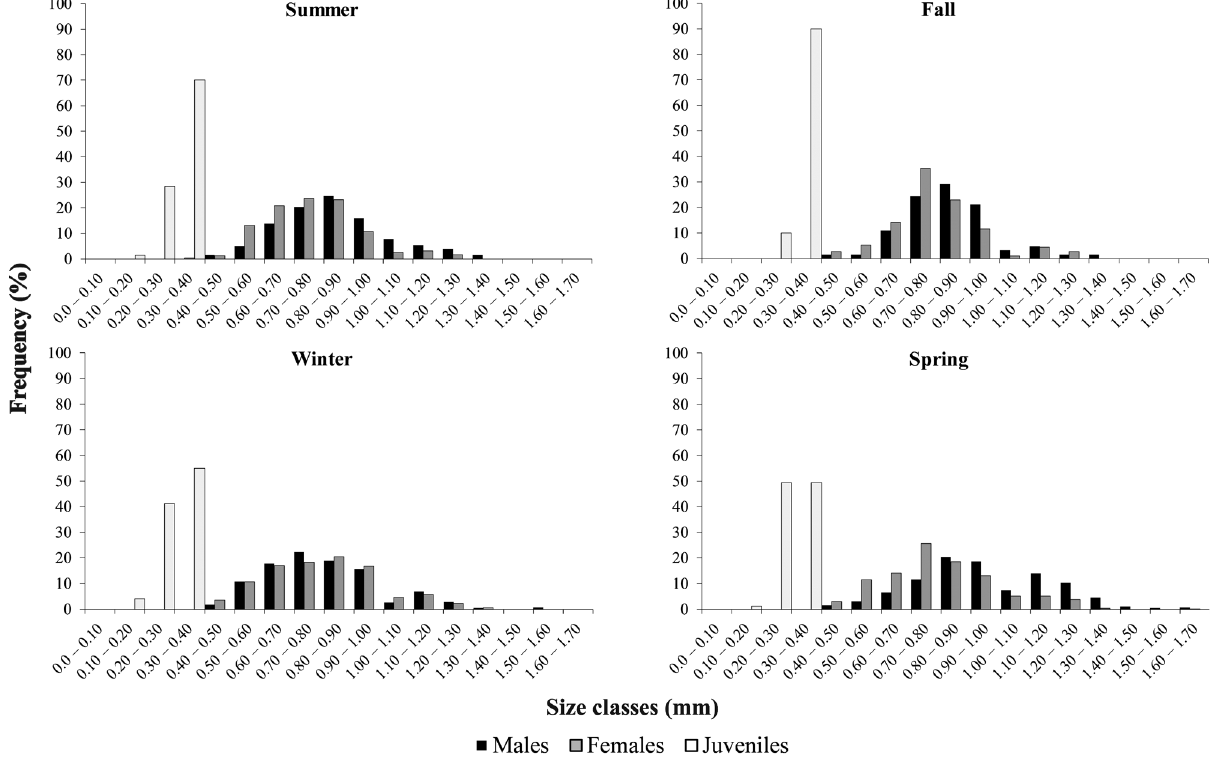
Figure 2. Seasonal size-frequency distribution of males, females and juveniles of Hyalella georginae , Palmeira das Missões, state of Rio Grande do Sul. Brazil. All sizes shown in the graph have at least one measured individual.